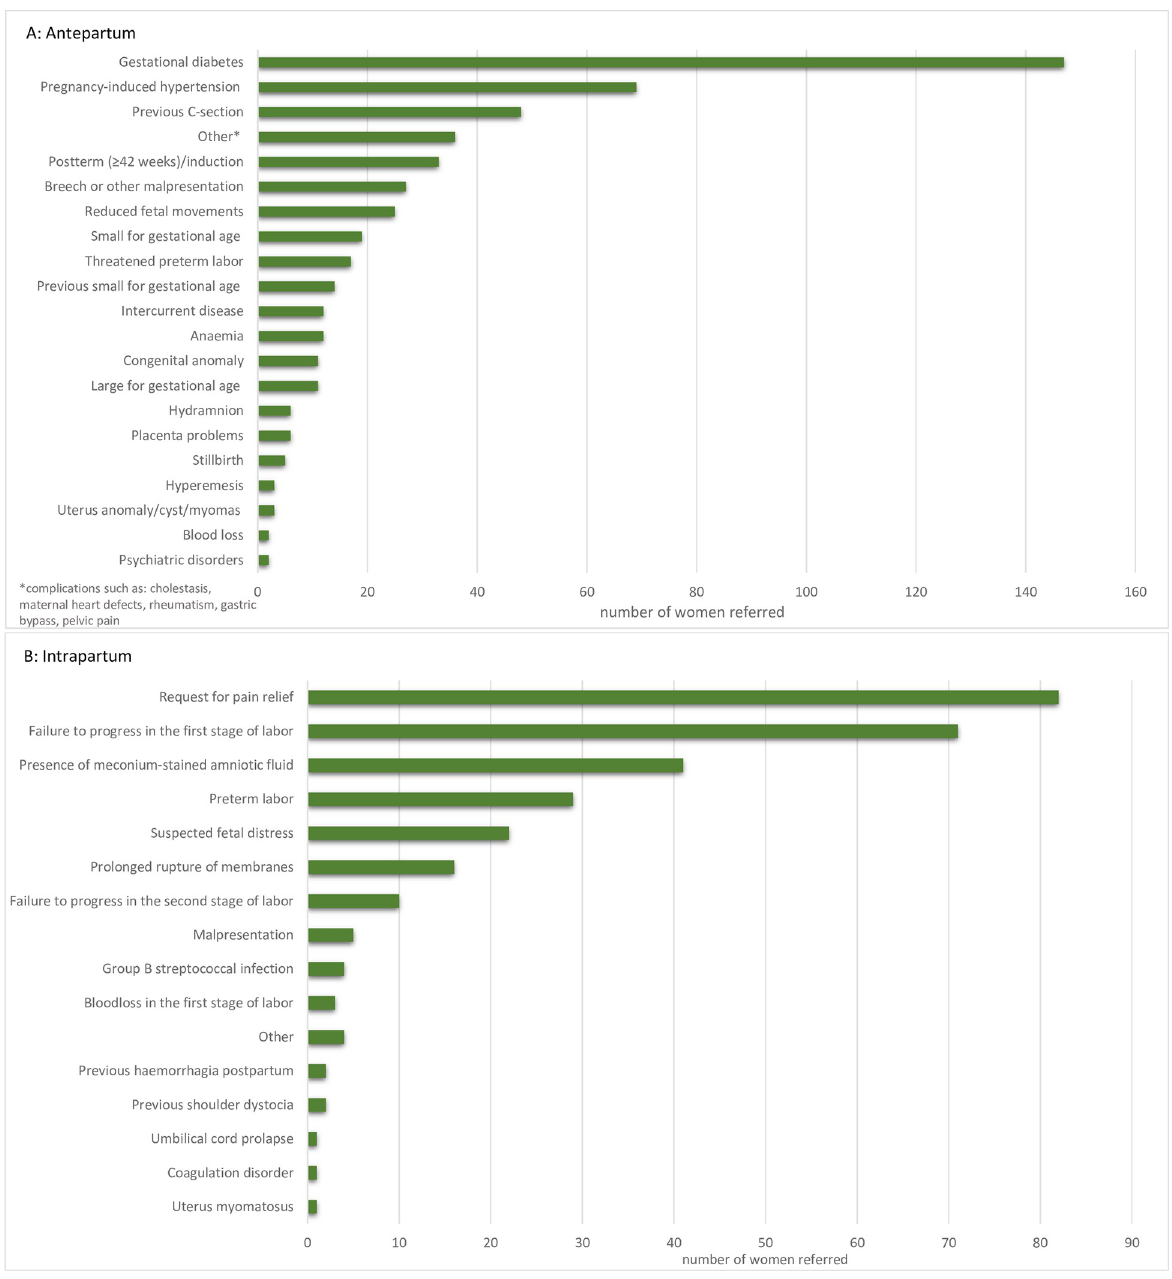
Fig 1. Reasons for referral antepartum & intrapartum. (A) Reasons for referral in the antepartum period. (B) Reasons for referral in the intrapartum